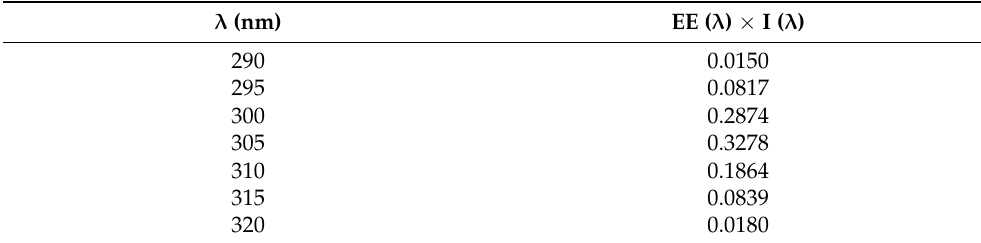
Table 4. Normalized EE ( λ ) x I ( λ ) values reported.